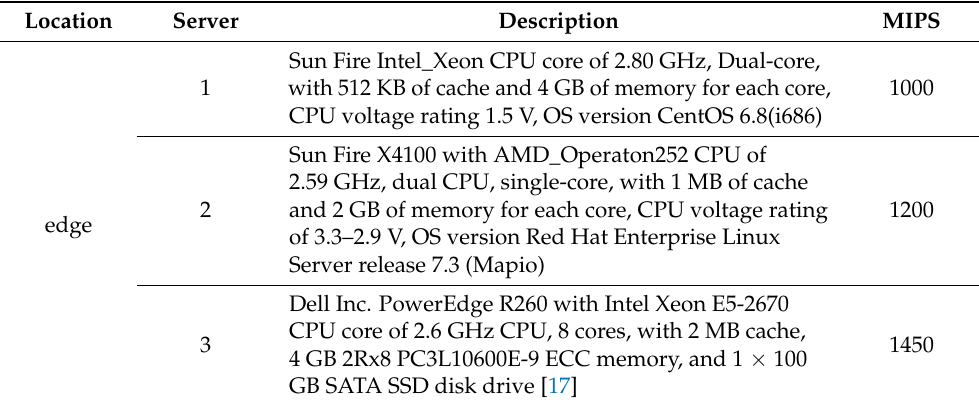
Table 3. Specifications of the servers’ types used in the